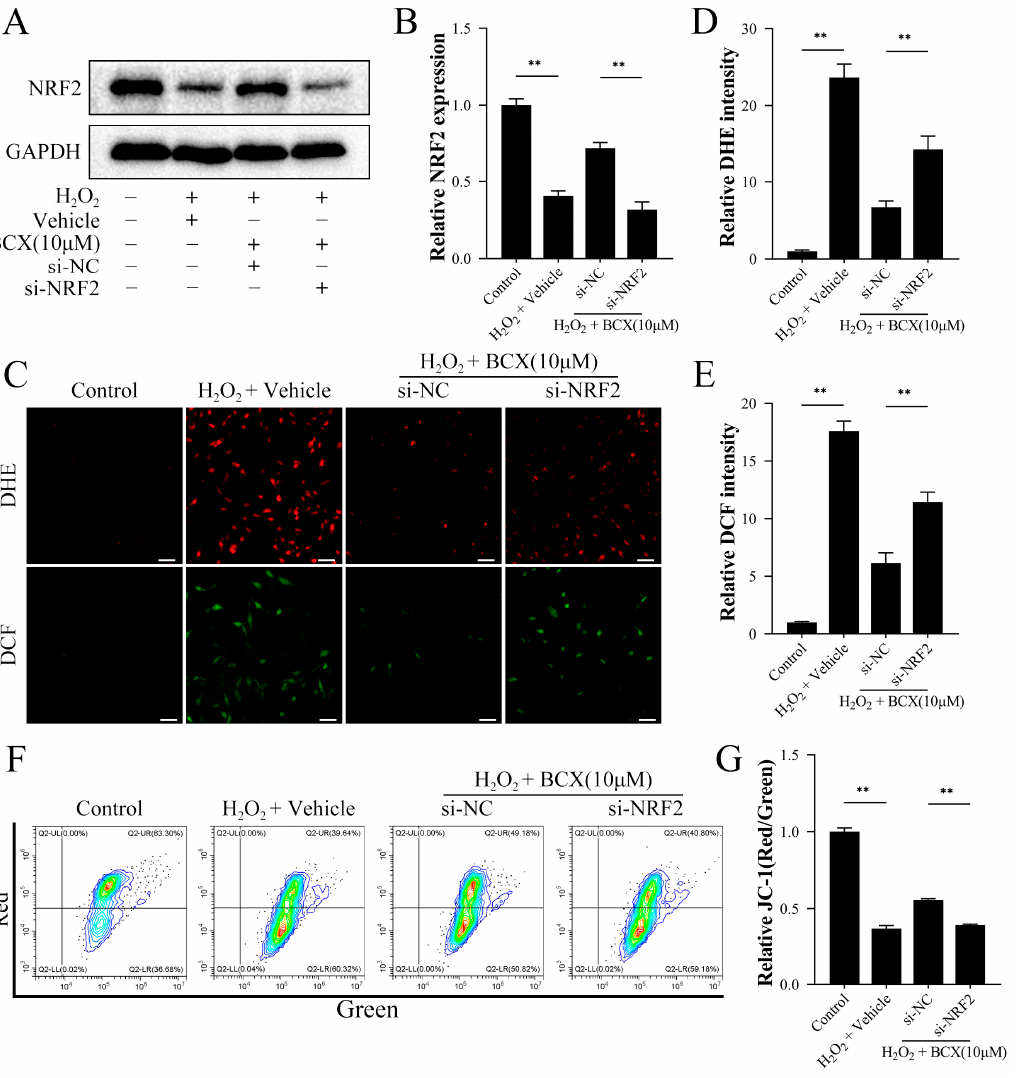
Figure 5. Inhibition of NRF2 reversed the protective effect of BCX against oxidative stress and restored mitochondrial membrane potential. HK-2 cells were transfected with negative control or si-RNA for NRF2 (si-NRF2). After transfection, HK-2 cells were pretreated with or without BCX (10 µ M) for 24 h and treated with 800 µ M H 2 O 2 for 48 h. ( A , B ) Western blot detection of NRF2 protein expression in HK-2 cells. The quantitative analysis was expressed as a relative value to GAPDH. ( C – E ) The levels of superoxide anion and reactive oxygen species in HK-2 cells were detected by DHE and DCF. Scale bar = 50 µ m ( F , G ) Flow cytometry detection of mitochondrial membrane potential levels in HK-2 cells. Values are expressed as mean ± SD. The mean value is the average of the results of three replicate experiments. n = 3. ** p <